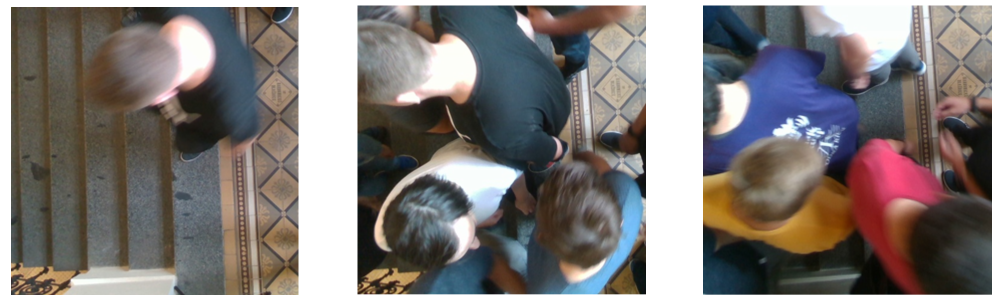
Figure 4. Some examples taken from the second